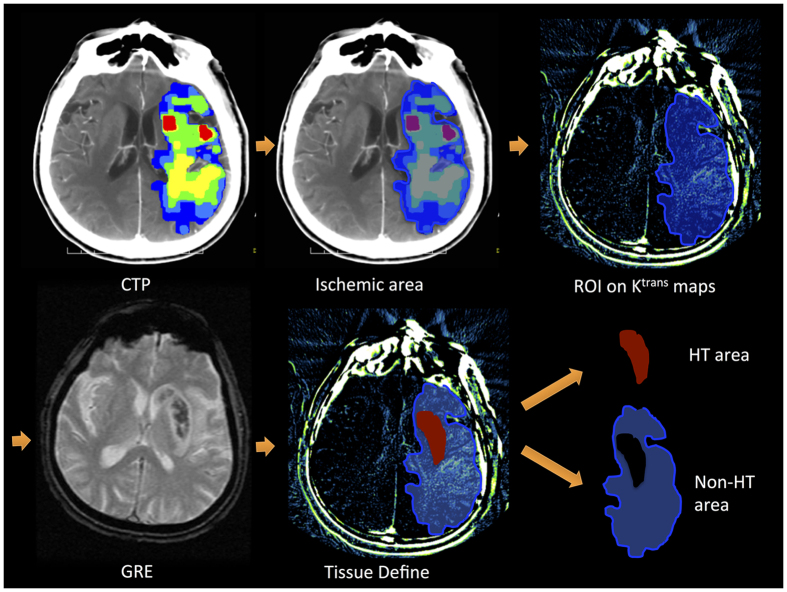
The protocol used to define the regions of interest (ROIs) for both hemorrhagic transformation (HT) and Non-HT areas on Ktrans maps.Step 1: The perfusion computed tomography (CTP) output images were used to draw the distribution of the ischemic area manually. Step 2: The ischemic area was overlapped on the Ktrans map to determine the ROIs, and all permeability values were restricted to this area. Step 3: ROIs were divided into HT areas and Non-HT areas, corresponding to the HT regions on the gradient recalled echo (GRE) T2-weighted magnetic resonance image.